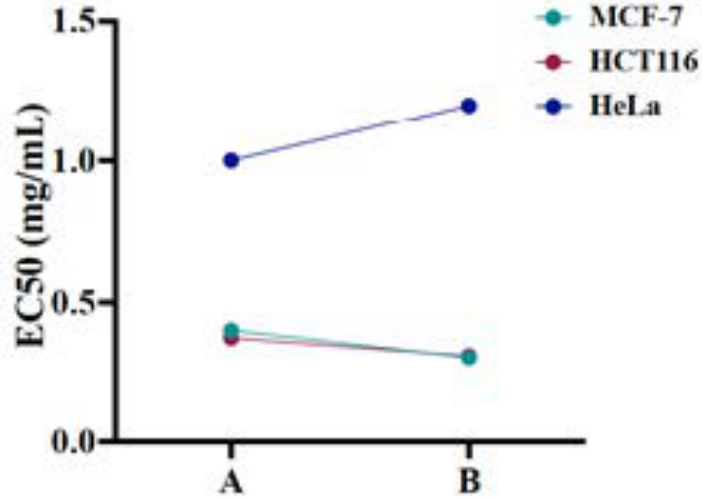
Figure 9. EC 50 values of β -Nb 2 ZnO 6 nanoparticles ( A ) and ( B ). Half maximal effective concentration (EC 50 ) of β -Nb 2 ZnO 6 ( A ) and ( B ) nanoparticles were determined for each cell line.